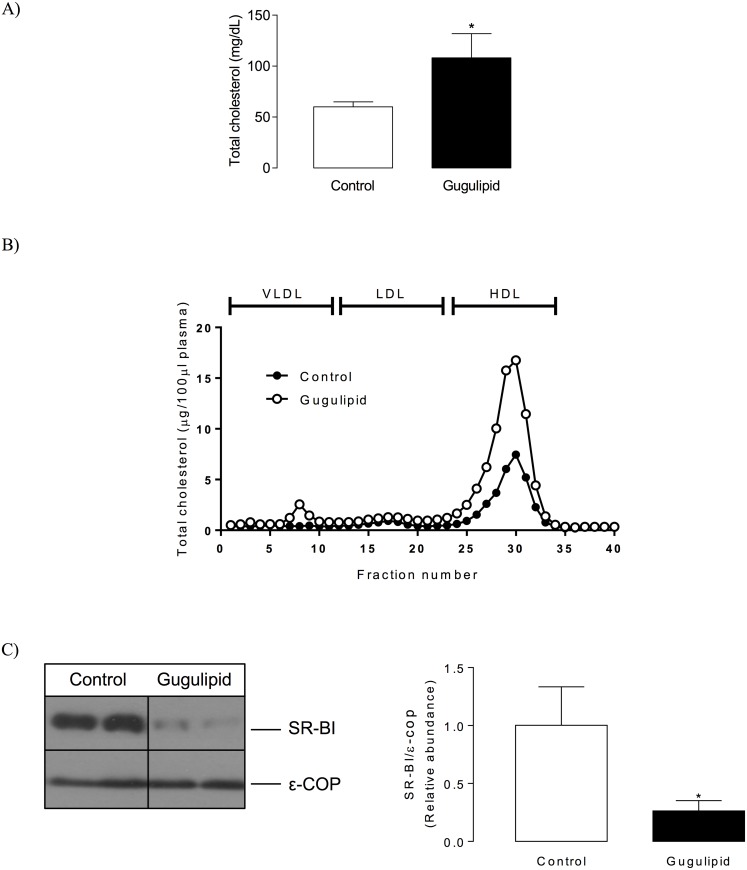
Effect of gugulipid on total and lipoprotein cholesterol levels and hepatic SR-BI level in male C57BL/6 mice.(A) Plasma total cholesterol level, (B) lipoprotein cholesterol distribution, and (C) western blot analysis (left) and quantitation (right) of hepatic SR-BI in control and gugulipid-treated mice. VLDL, very low-density lipoprotein; LDL, low-density lipoprotein; HDL, high-density lipoprotein. ε-COP served as loading control. Two independent experimental sets were analyzed; n = 6 in each set. Values represent mean ± SD. *P<0.05.